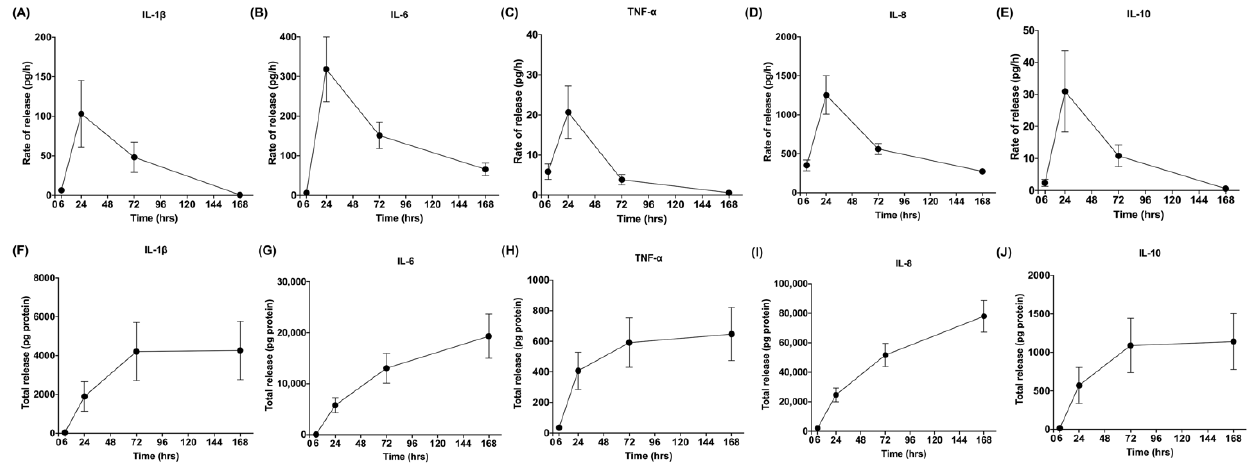
Figure 3. Rate of release and total release of cytokines. The figure shows the rate of release and total release of the tested cytokines from the L-PRF membrane up to 168 h. Panels ( A , F ) display IL-1 β , ( B , G ) IL-6, ( C , H ) TNF- α , ( D , I ) IL-8, ( E , J ) and IL-10 for rate of release and total release, respectively. Mean ± SEM are displayed at each time point.